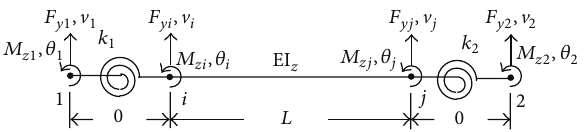
Figure 1: Frame element with rotational springs.